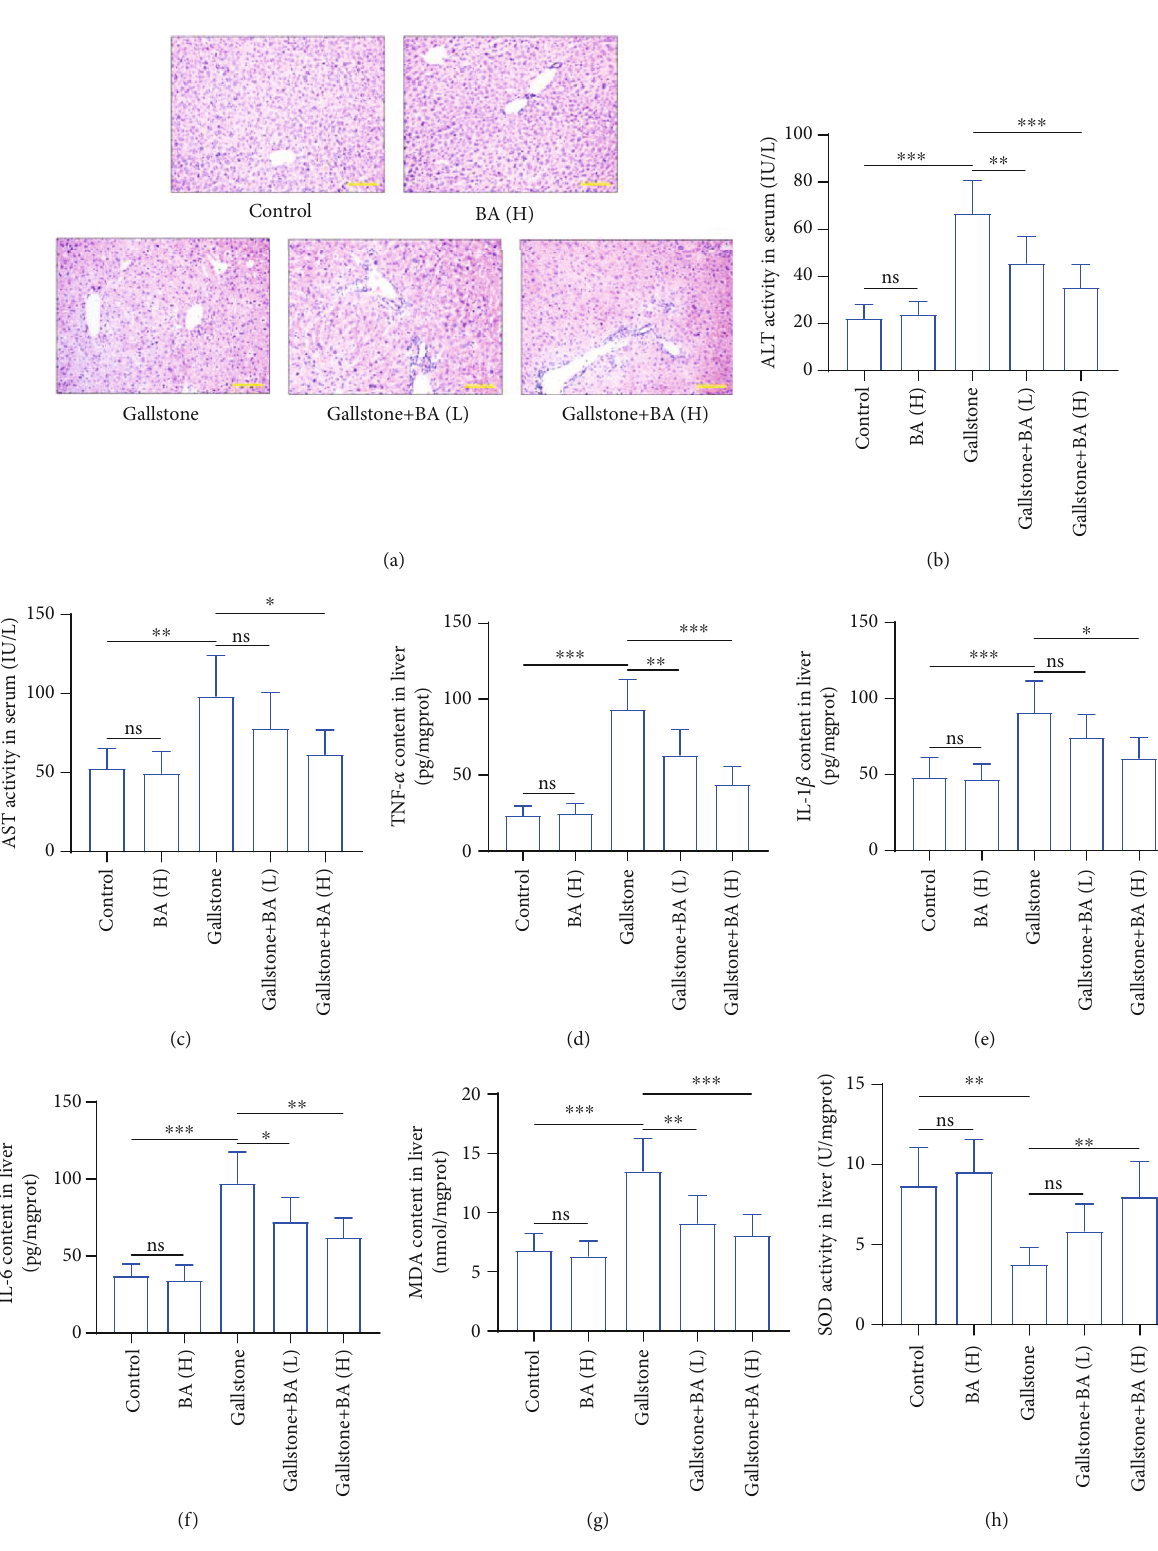
Figure 4: Baicalin attenuated lithogenic diet-induced damage in liver. (a) HE staining was performed to determine the pathological and physiological characteristics of the liver (the scale bar represented 100 μ m). (b, c) The activity of alanine aminotransferase (ALT) (b) and aspartate aminotransferase (AST) (c) in serum. (d – f) The content of in fl ammatory factors tumor necrosis factor- (TNF-) α (d), interleukin- (IL-) 1 β (e), and IL-6 (f) in the liver was detected by ELISA. (g) The malondialdehyde (MDA) content in the liver. (h) The enzymatic activity of superoxide dismutase (SOD) in the liver. n = 6 ( ∗ p < 0 : 05 , ∗∗ p < 0 : 01 , and ∗∗∗ p < 0 : 001 ). ns: no signi fi cance; BA(L): 50mg/kg baicalin; BA(H): 100 mg/kg